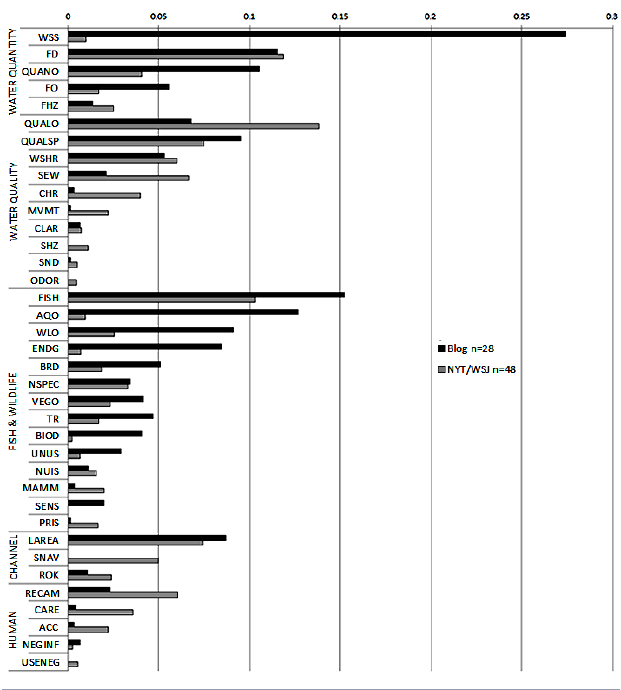
Fig. 2 . Motivation normalized frequencies, see Appendix 1 for long form code